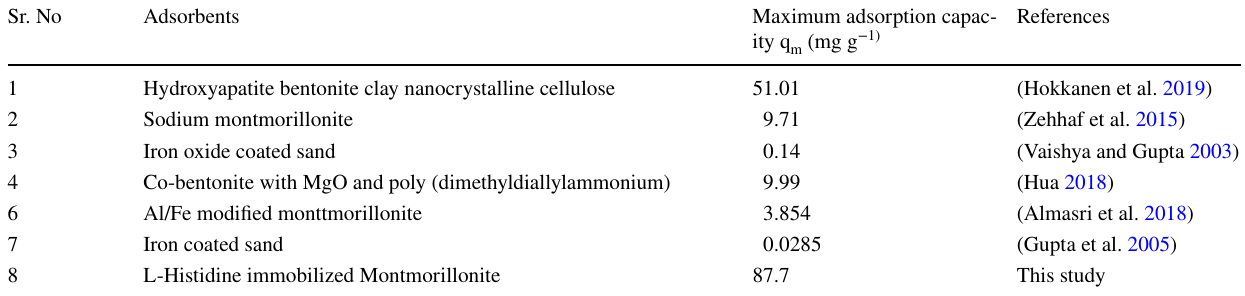
Table 4 Comparison of L-Histidine immobilized montmorillonite with different clay based adsorbents for As(III) removal Sr.